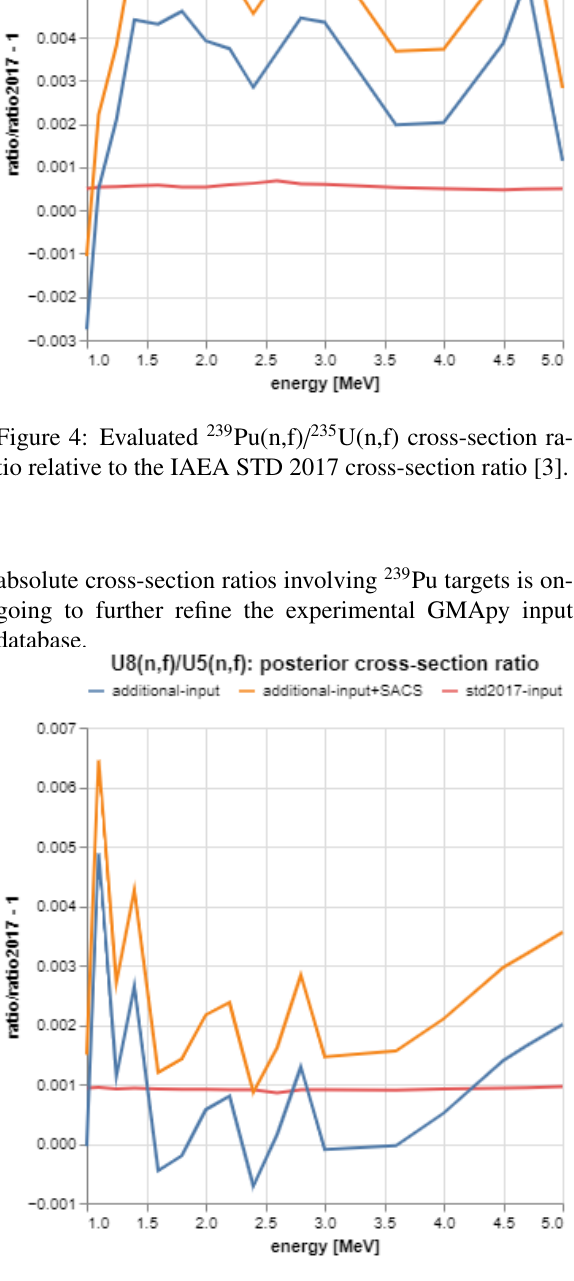
Figure 5: Evaluated 238 U(n,f) / 235 U(n,f) cross-section ratio relative to the IAEA STD 2017 cross-section ratio [3].